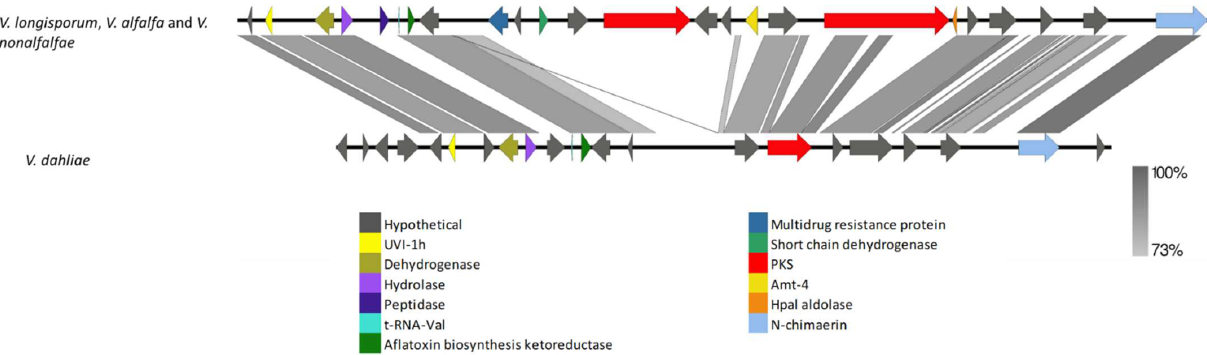
Figure 12. Comparison of VRPKS-I-11 gene cluster among pathogenic strains of Verticillium . VRPKS- I-11 was absent in V. dahliae but was present in V. longisporum , V. alfalfae , and V. nonalfalfae .